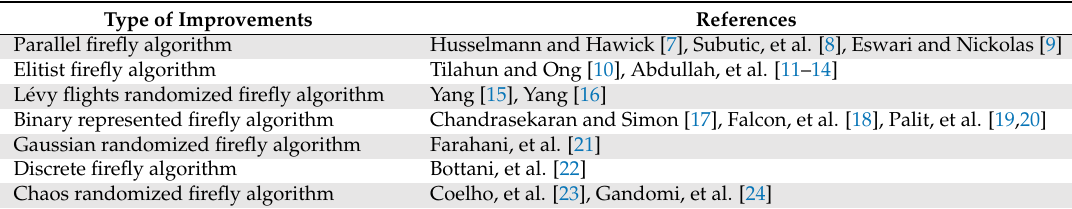
Table 1. Classification of modified FA in